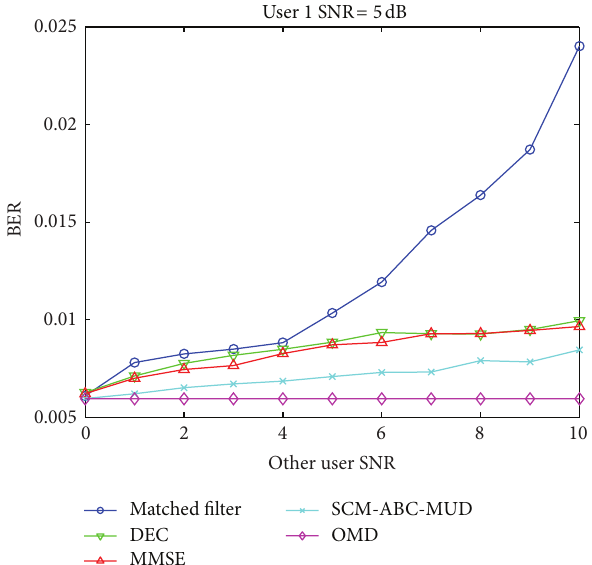
Figure 5: Near-far effect resistant of different MUD algorithms.